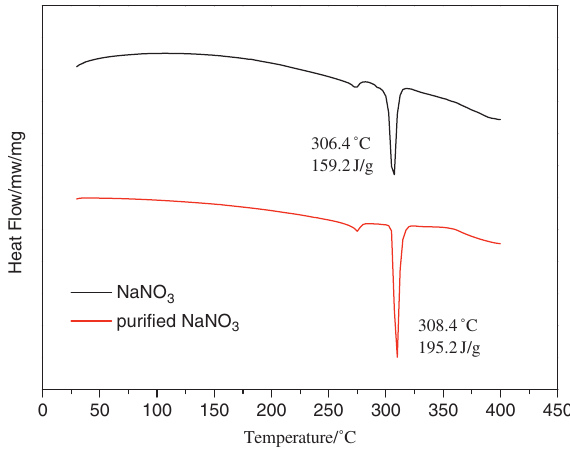
Figure 7: DSC curves of sodium nitrate molten salt and purified sodium nitrate molten salt.